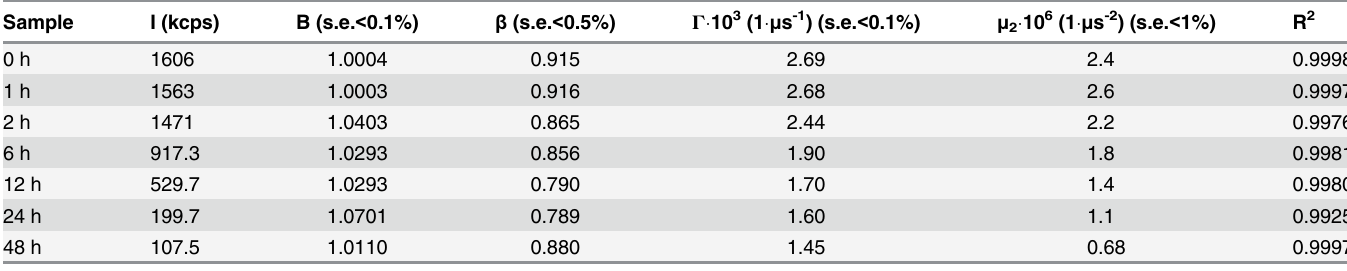
Table 1. Results of the fit to Eq (3) to DLS data of the HPV16 virus like particles studied.